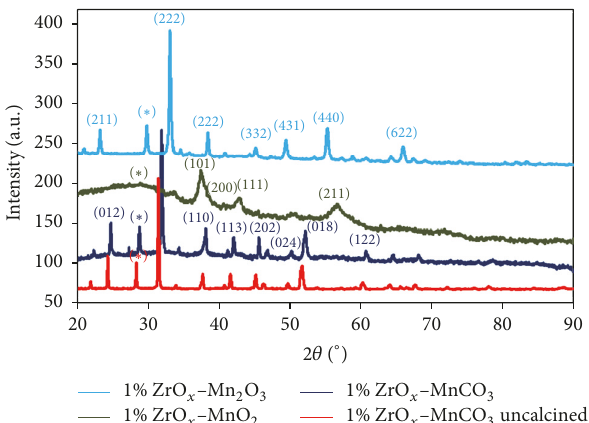
Figure 3: XRD pattern of the catalyst at different temperatures 1% ZrO –MnCO 3 uncalcined; 1% ZrO x 1% ZrO –Mn 2 O 3 . x